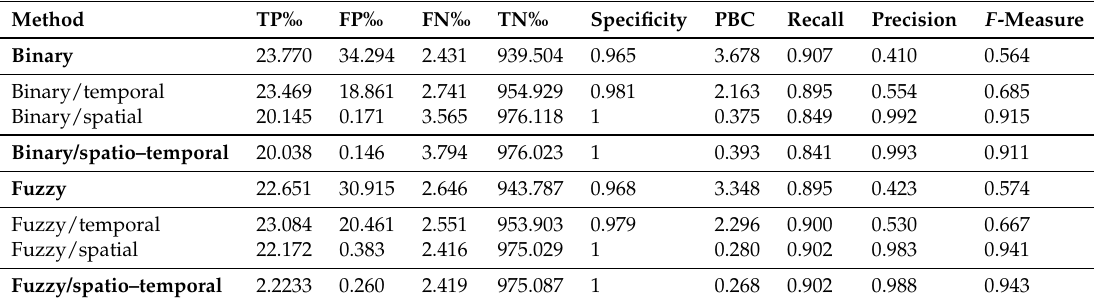
Table 5. Performance of each variant, video